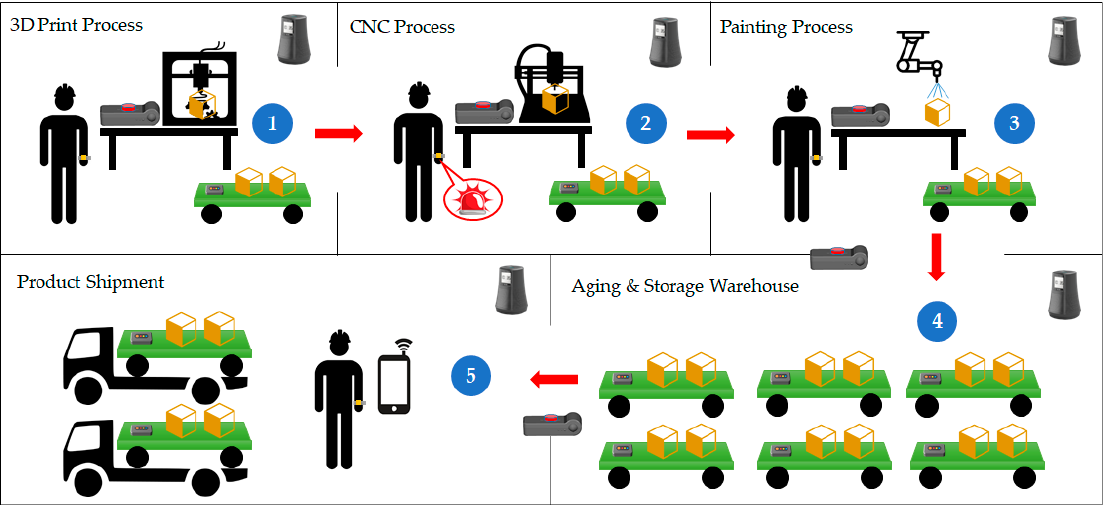
Figure 3. Opportunistic service scenario.